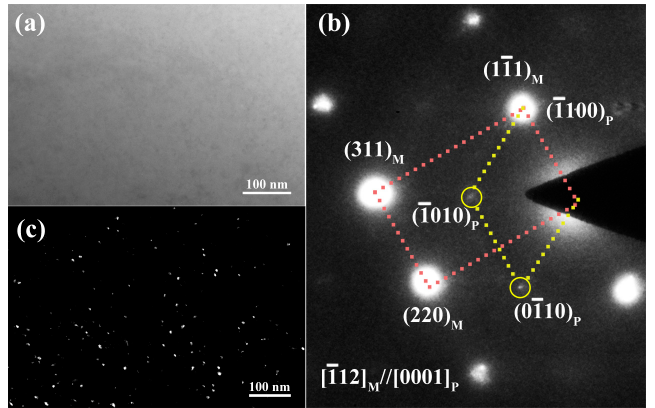
Figure 1. Micrographs and selected area electron diffraction (SAED) pattern of CdZnTe (CZT) crystals grown by the traveling heater method (THM) with slow cooling rate along the ( a ) Bright-field transmission electron microscopy (TEM) micrograph along the ( b ) Dark-field TEM micrograph along the zone axis.